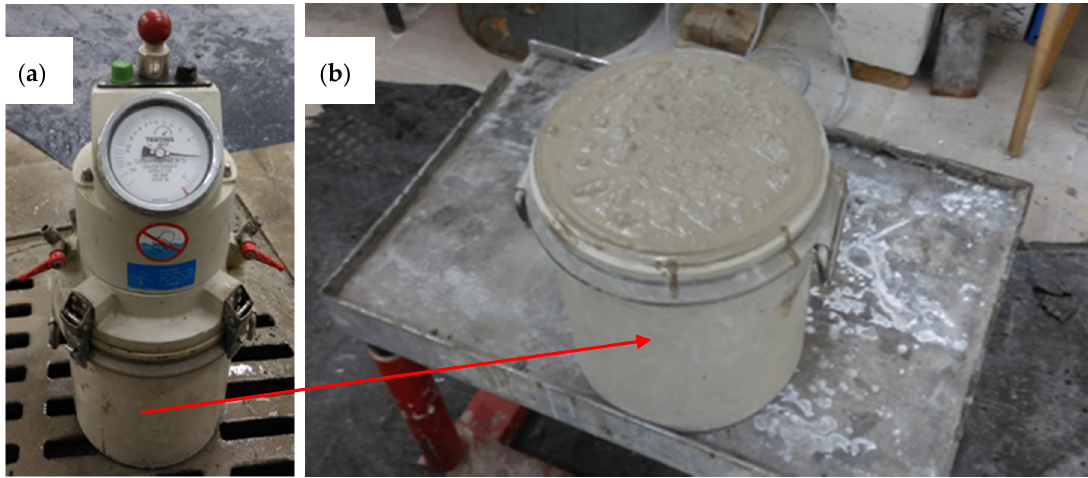
Figure 4. The pressure method ( a ) pressure porosimeter (Merazet, Pozna ń , Poland), ( b ) bottom porosimeter container filled with a mixture of mortar with 5% of glass aggregate.